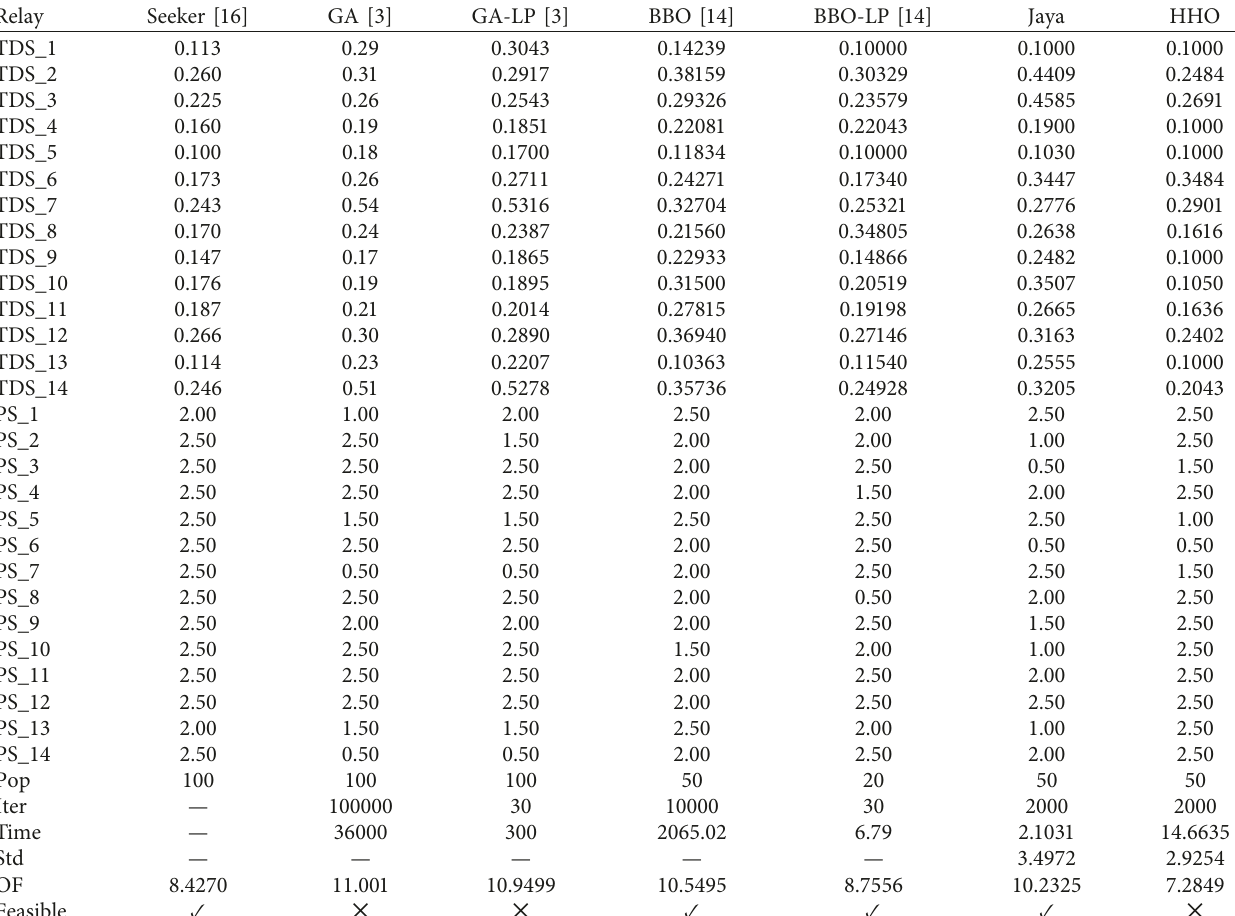
Table 11: Time dial setting and pickup current for the 8-bus system by MINLP